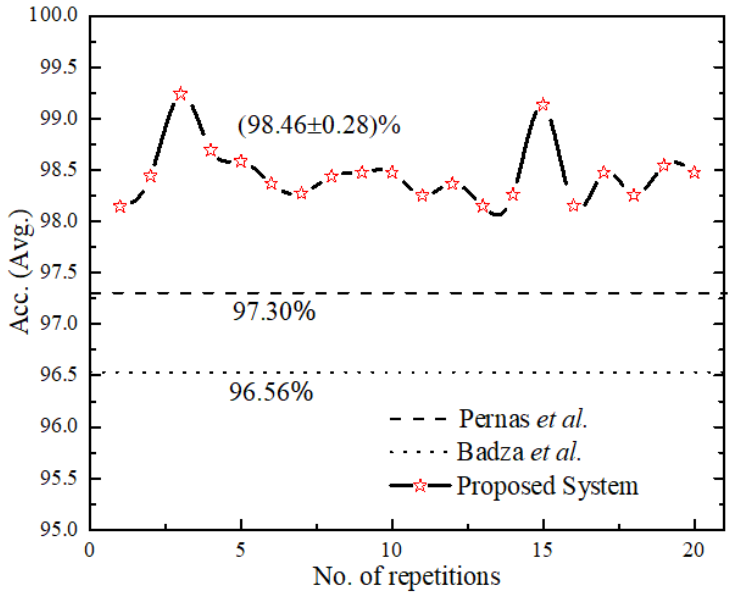
Figure 9. Result of a consecutive run of the proposed system and for comparison with [25,32] their number of repetitions have been assumed constant. Table 9. Comparison of best-known results with proposed work in the light architecture category (same dataset).